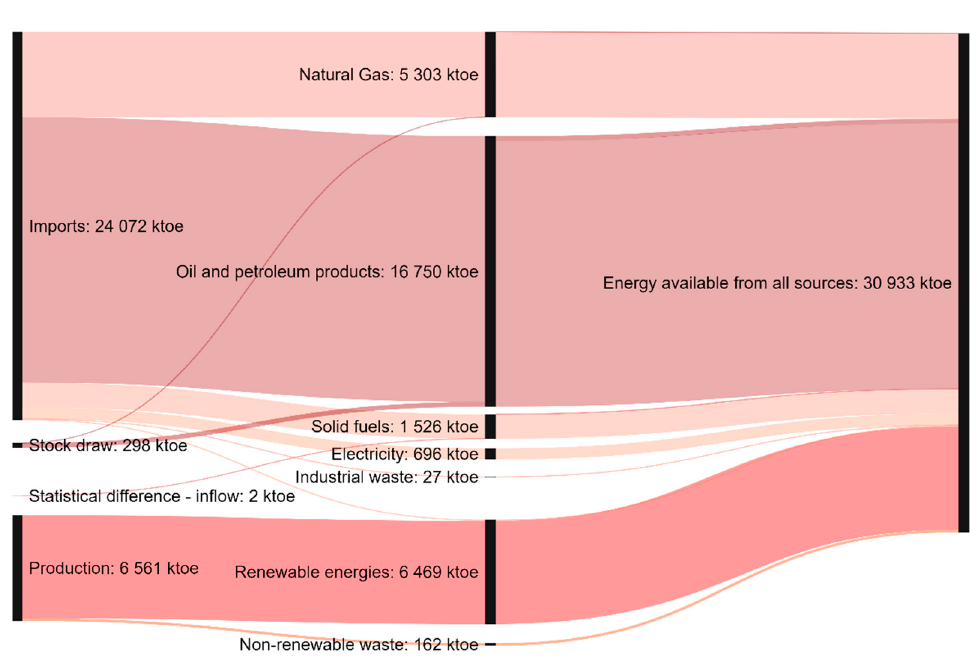
Figure 12. Portuguese energy balance flow for energy available from all sources–2019 data (adopted from Eurostat data).